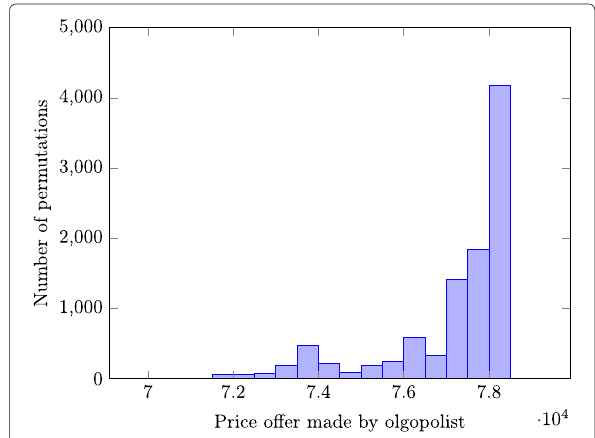
Fig. 6 Histogram of total price offers made by the oligopolist from 10000 random permutations